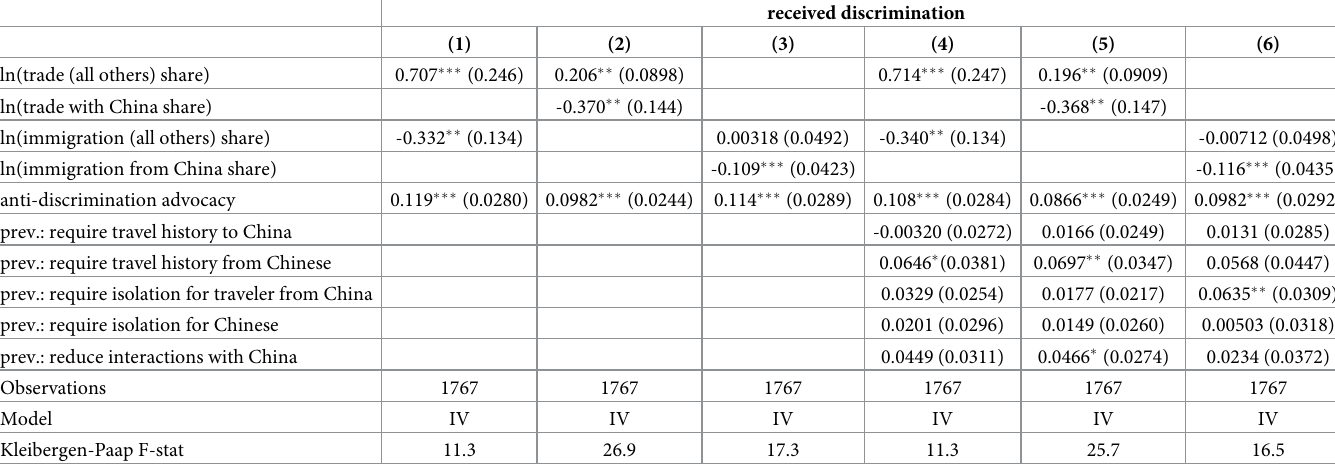
Table 5. Mitigating factors: Anti-discrimination advocacy, measures of disease control and prevention.